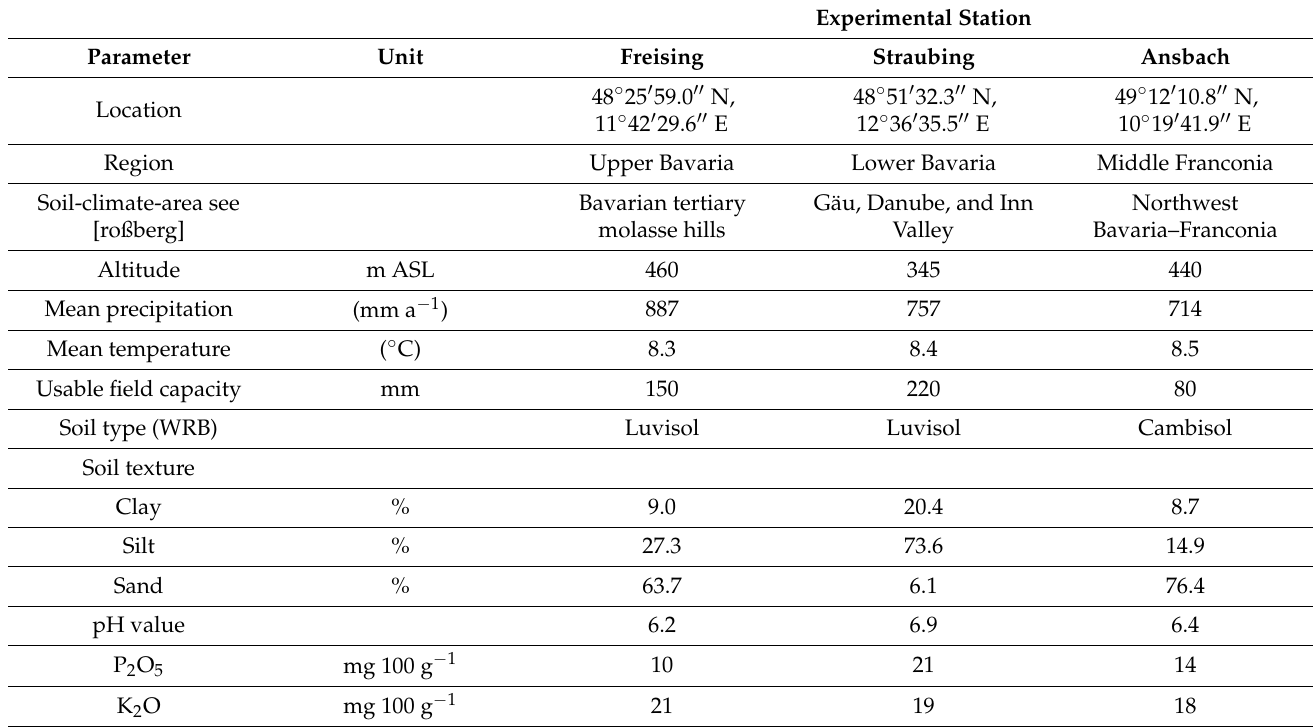
Table 1. Site and soil conditions (at 0–30 cm depth) of the three field